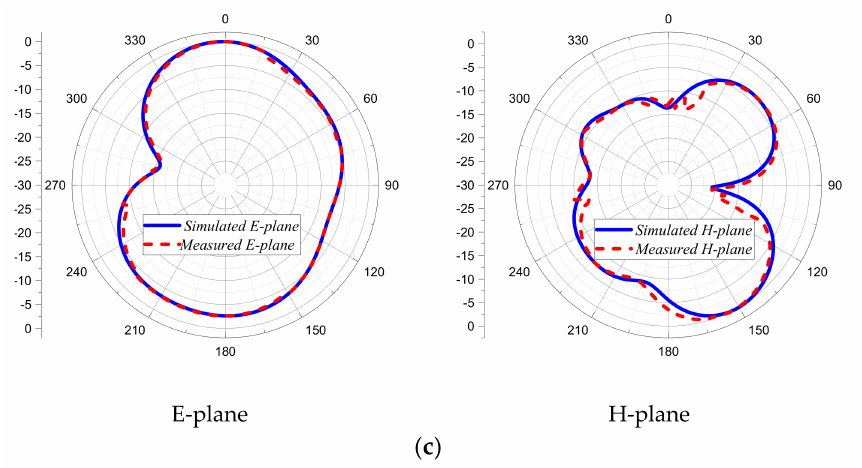
Figure 13. Measured and simulated normalized 2D radiation patterns of the designed Sierpinski hexagonal-shaped fractal antenna in the E-plane and H-plane at ( a ) 2.4 GHz; ( b ) 6.6 GHz; ( c ) 9.8 GHz. Figure 14 depicts the simulated and measured co-polar and cross-polar 2D radiation patterns in both the E-plane and H-plane. The cross-polarization decreased in the E-plane, from lowest to greatest resonances, and increased in the H-plane due to the presence of cross-field constituents in the lower part of the patch and feed line. It was demonstrated that when the frequency rose, the fractal antenna lost its omnidirectional pattern and produced a greater cross-polarization component in the H-plane as a result of the emergence of higher-order modes.